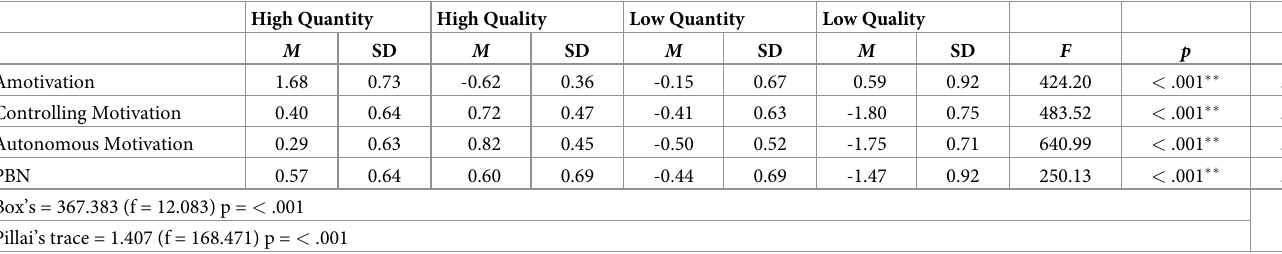
The nonhierarchical cluster confirmed the four-cluster solution (Fig 1 and Table 2). The first profile was denominated “high quantity” (n = 103, 13.4%) with high values in all variables, the second profile “high quality” (n = 310, 40.4%) had high levels in autonomous, controlling motivation and BPN and low levels of amotivation, the third profile (n = 269, 35%) was denominated “low quantity” with low values in all variables. Finally, the fourth profile “low quality” (n = 86, 11.2%) with low values in autonomous and controlling motivation and BPN and high amotivation levels. On the other hand, Table 2 shows the differences among the variables that configured the cluster solution. They had a multivariate effect (Box’s value = 367.383, f = 12.083, p = < .001), pointing to the violation of the assumption of homogeneity of Table 2. Differences in variables from motivational